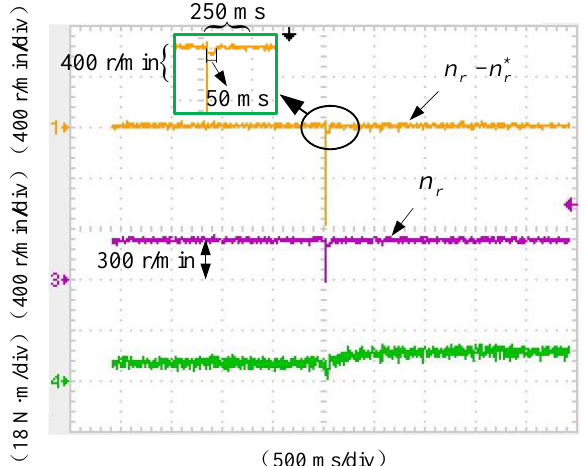
Figure 24. Experimental results of TIBC-DTC.